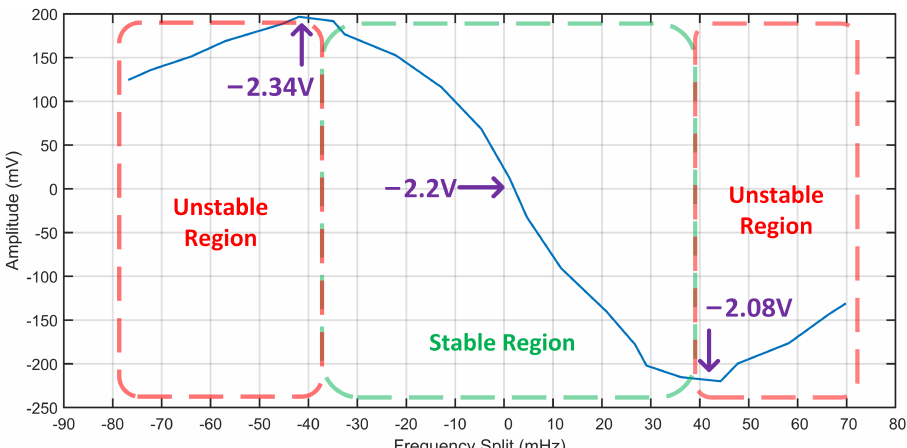
Figure 9. The stability range of the closed-loop control system.